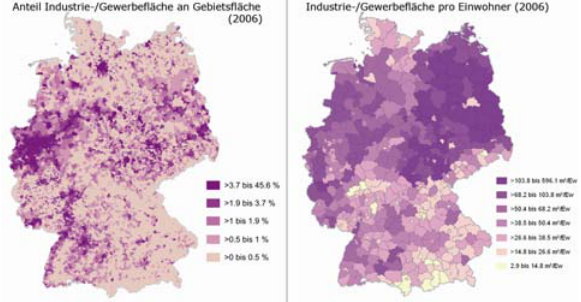
Figure 5. left: percentage of the industrial/commerce area (municipalities), right: industrial/commerce area per inhabitant (counties) for